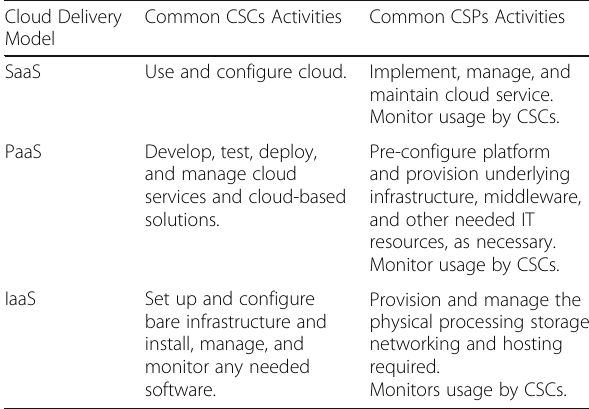
Table 2 Cloud consumers and cloud providers responsibilities in relation to the cloud delivery